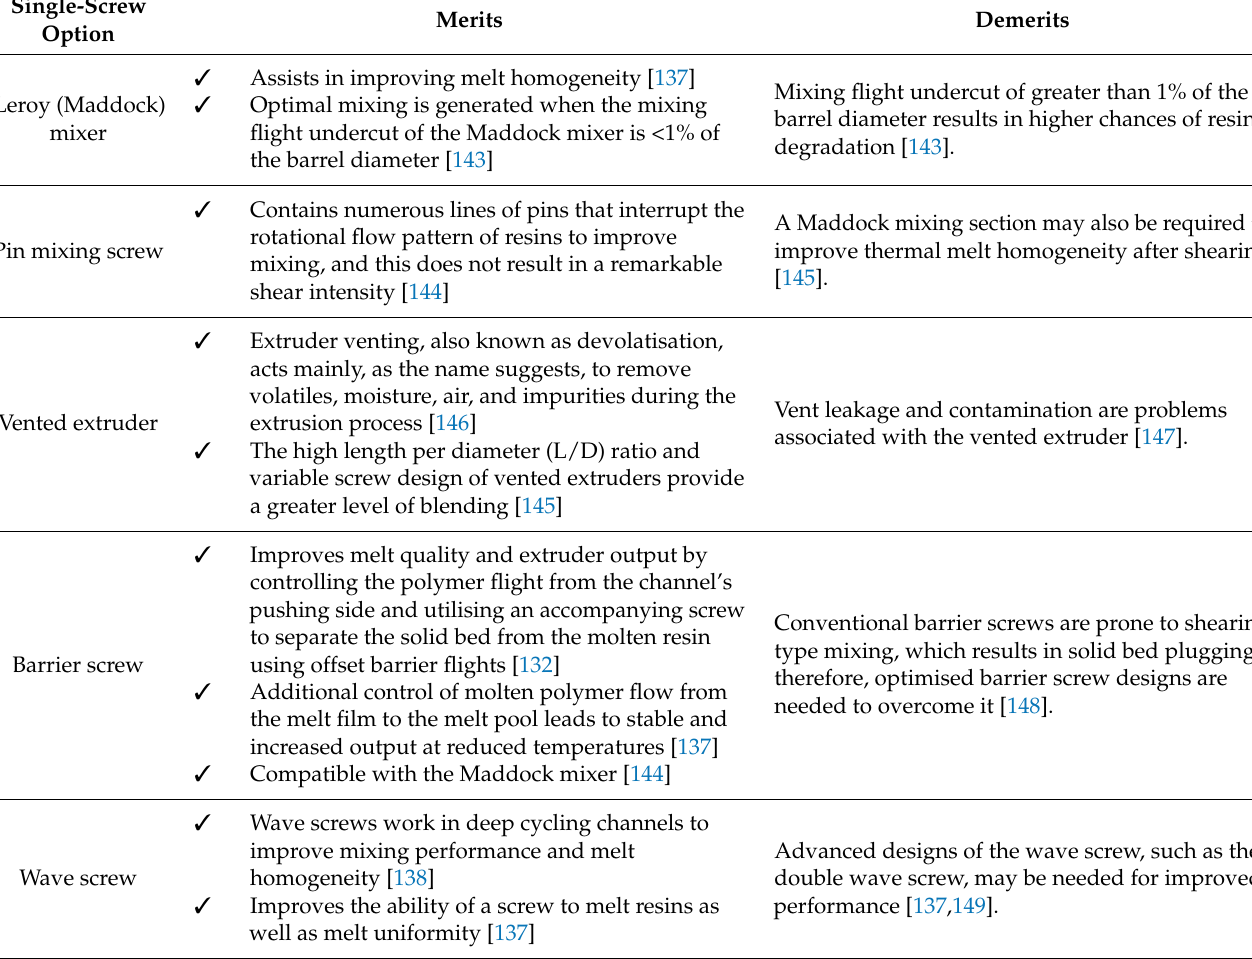
Table 3. Merits and demerits of single-screw extruder